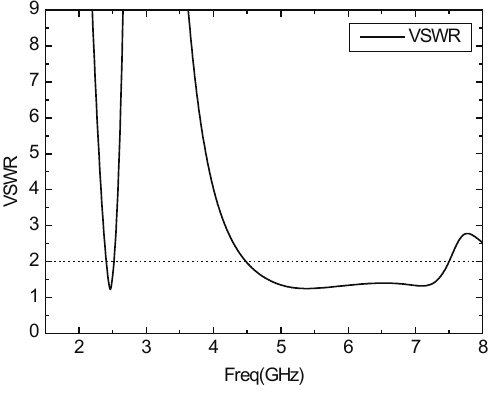
Figure 10. VSWR curve of the antenna.